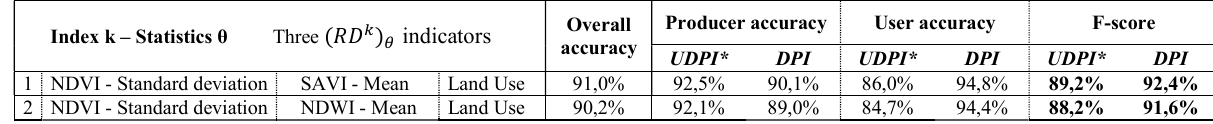
Table 4 . Best results from 2-variable supervised classifications by Gaussian process over validation sample ( UDPI *: half of UDPI ).